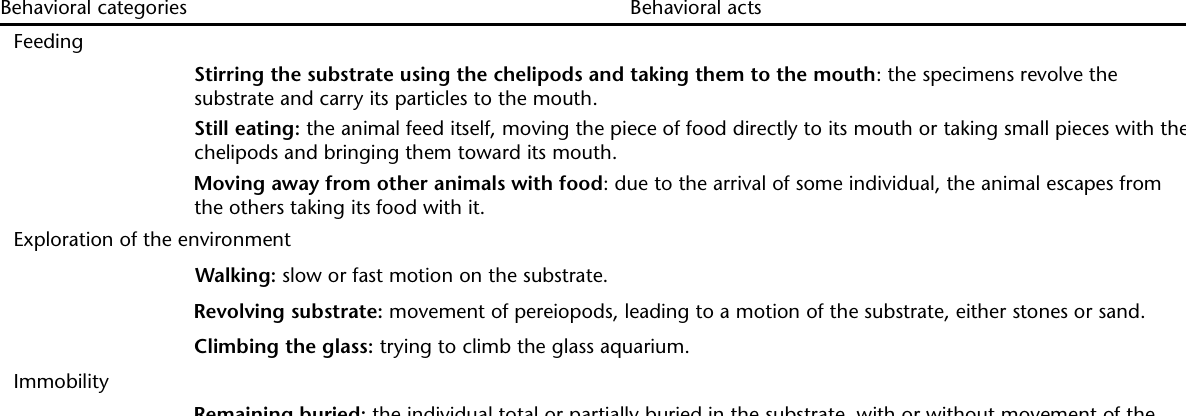
Table I. Trichodactylus panoplus : description of behavioral acts under laboratory